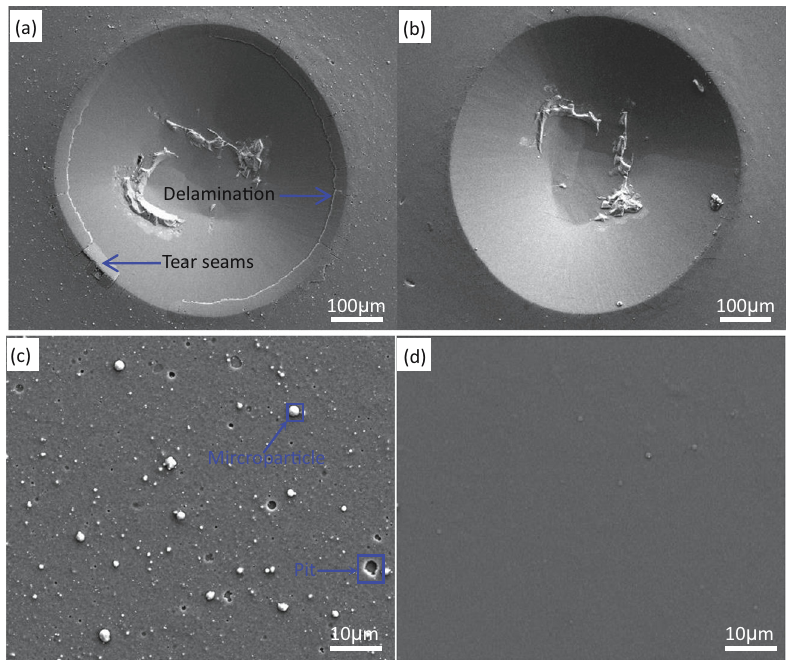
Figure 2: Rockwell indentation and surface microstructure of as - deposited coatings A ( a and c ) and B ( b and d ) .